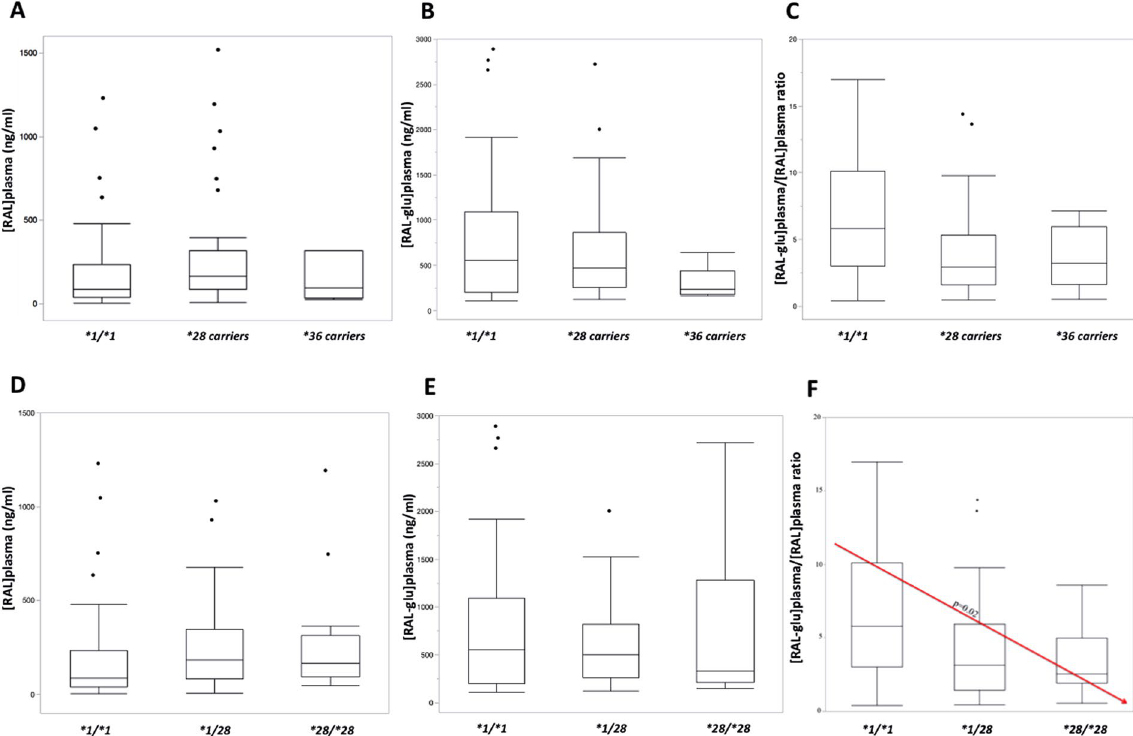
Figure 2. [RAL]plasma ( A ), [RAL-glu]plasma ( B ) and [RAL-glu]plasma/[RAL]plasma ratio ( C ) according to UGT1A1 * 1/ * 1, UGT1A1 * 28 carriers and UGT1A1 * 36 carriers. [RAL]plasma ( D ), [RAL-glu]plasma ( E ) and [RAL-glu]plasma/[RAL]plasma ratio ( F ) according to UGT1A1 * 1/ * 1, UGT1A1 * 1/ * 28 and UGT1A1 * 28/ *